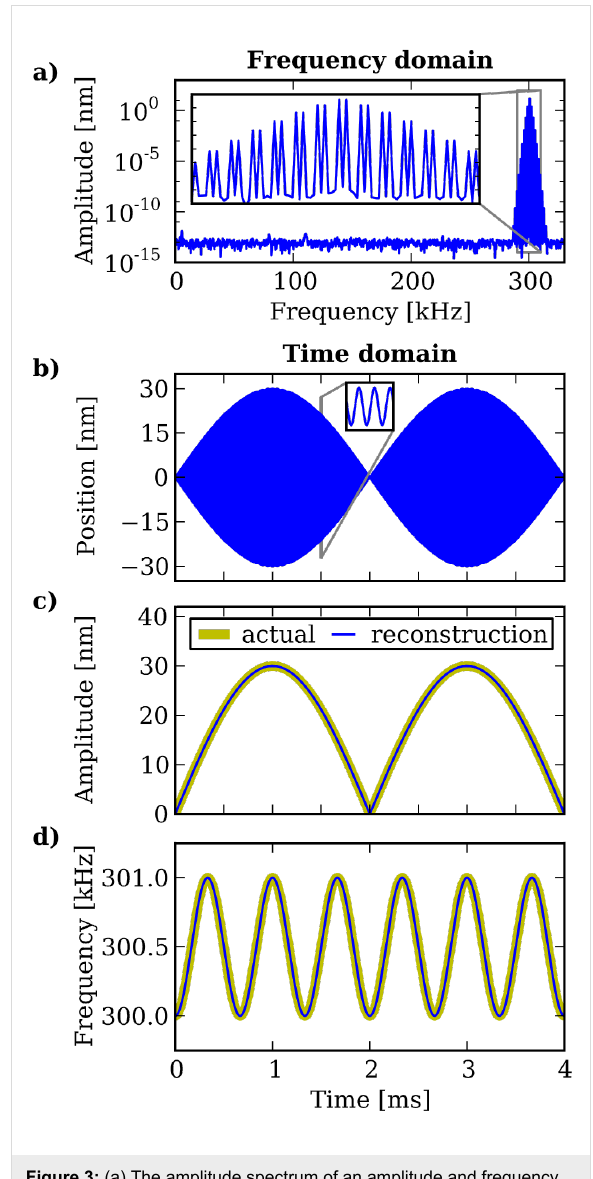
Figure 3: (a) The amplitude spectrum of an amplitude and frequency modulated signal. The response is concentrated in a narrow-band frequency comb with a center frequency much higher than the comb base frequency. In the time domain (b) the signal rapidly oscillates on a short time scale and the slow amplitude modulation is clearly visible. The time-dependent amplitude (c) and frequency (d) reconstructed from the envelope function are in excellent agreement with the actual modulation used for the signal generation in the time